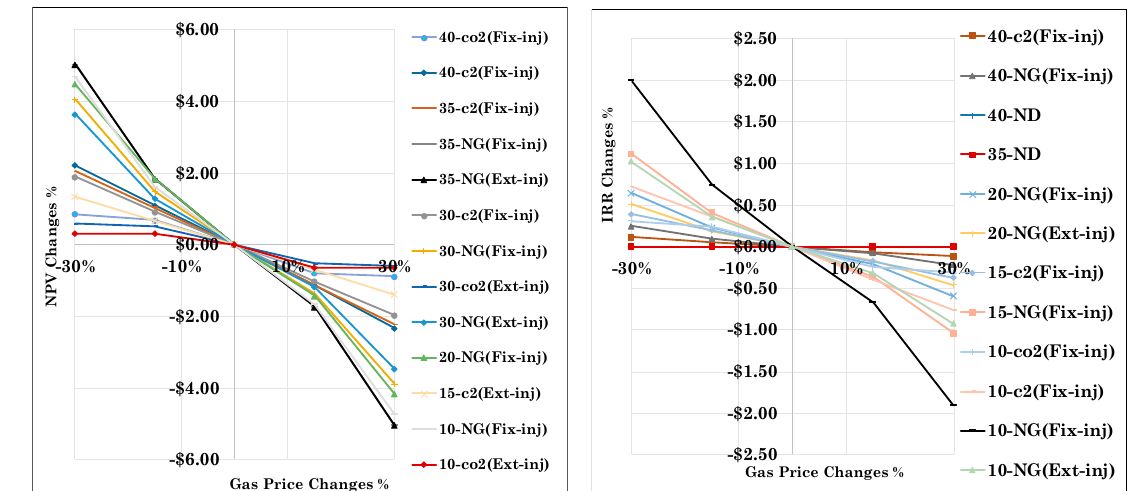
Figure 34. Changes in NPV and IRR coming from variation in Oil Price